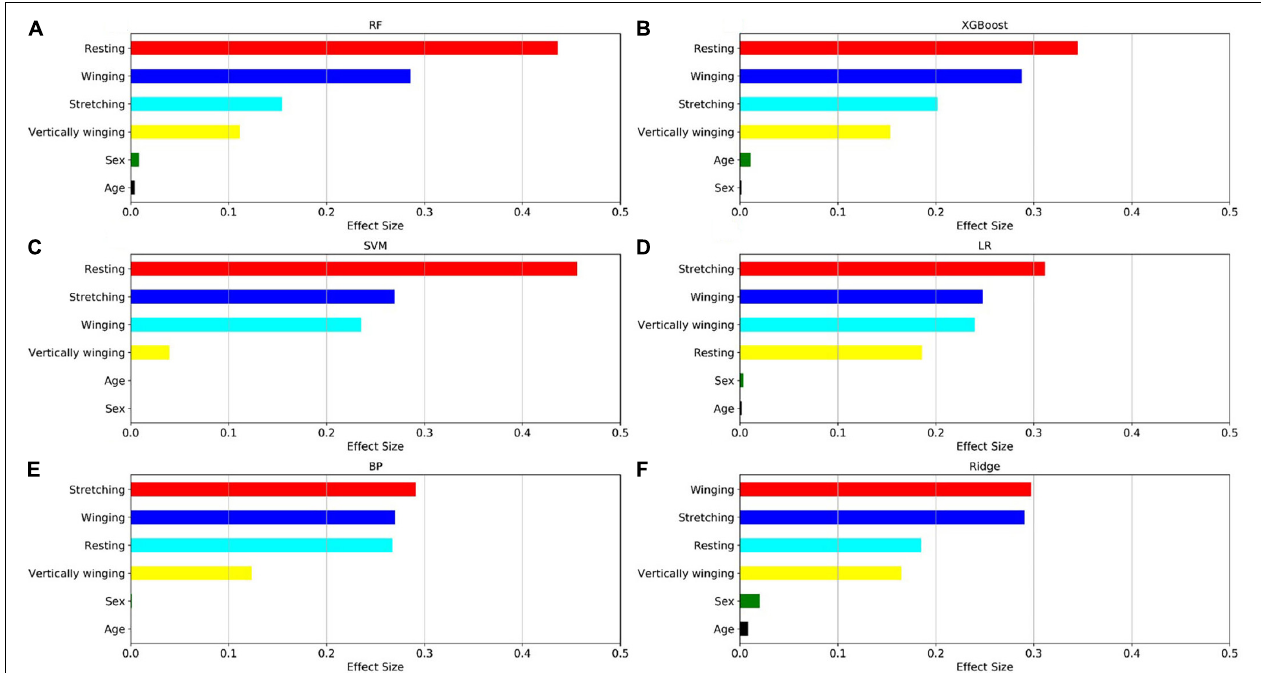
FIGURE 6 | Factors effect size. The (A–F) histogram displays the proportion of the factoric importance of sex, age, and four postures calculated by the models. For each model, the relative importance is quantified by assigning a weight between 0 and 1 for each variable and then the relative importance of the four postures is calculated by the sum of the factoric importance of the corresponding variables affiliated to that posture. The models XGBoost and RF allow the importance of variables to be derived during model training; the coefficients of the Ridge model are used as the basis for factor importance; the LR, BP, and SVM models are obtained by the Mean decrease accuracy